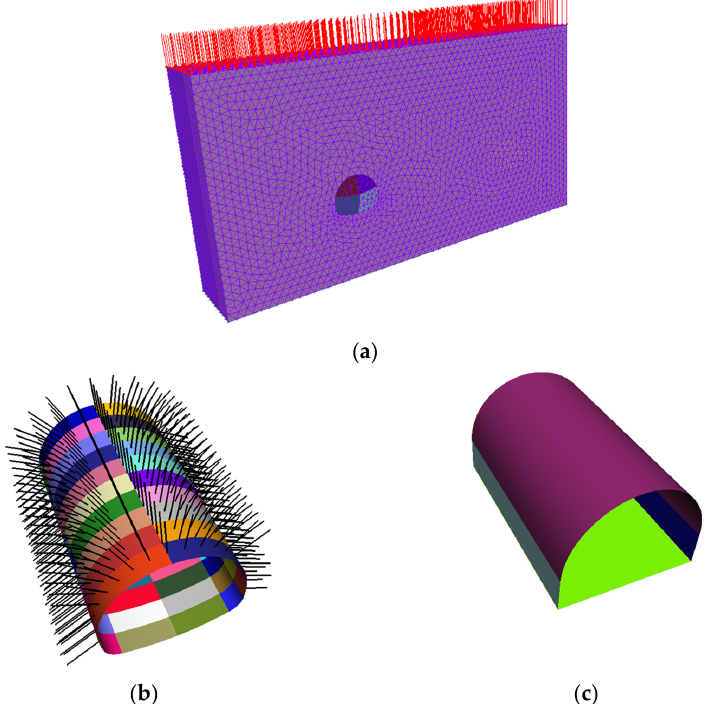
Figure 5. Primary support under the excavating process. ( a ) part I (step 2); ( b ) part II (step 6); ( c ) part III (step 20); ( d ) part IV (step 28).